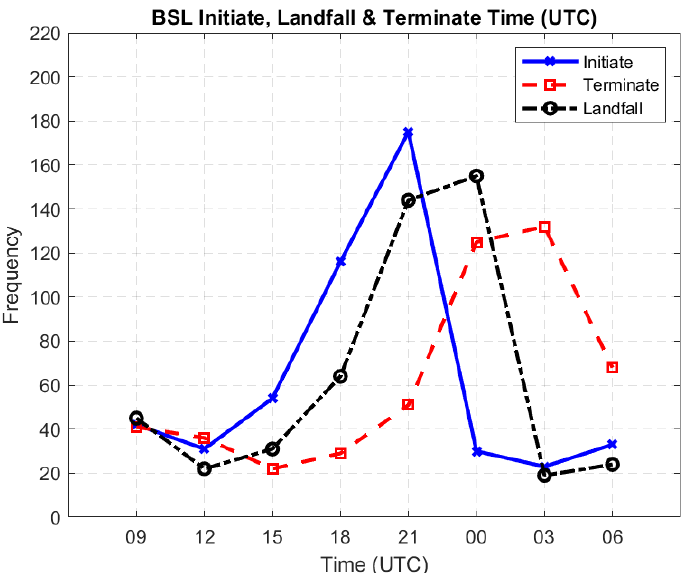
Figure 5. BSL initiation, landfall and termination times. The Time–Frequency series are based on 3-hourly accumulated rainfall data.